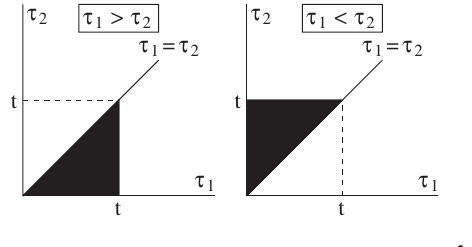
FIG. 14. Domain of integration (thick black line) of R R t t d(cid:8) d(cid:8) f e (cid:1) 2 (cid:4) t (cid:8) 1 (cid:1) 2 (cid:4) t (cid:8) 2 h f ð (cid:8) Þ f ð (cid:8) Þig depending on the rela- 1 2 1 2 1 2 0 0 tionship between t and t . 1 2